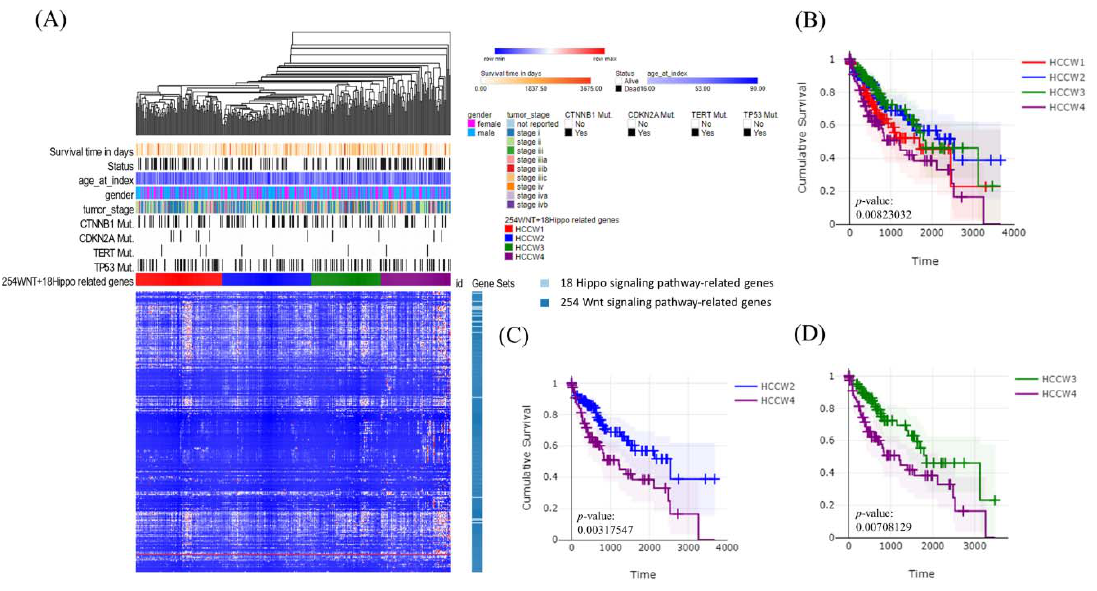
Figure 4. Molecular classification of HCC data from The Cancer Genome Atlas (TCGA) using a panel of 272 Wnt–Hippo pathway genes. ( A ) Heatmap showing normalized expression levels of 272 signature genes (rows) across subjects (columns) divided into four molecular subclasses (HCCW1– 4), where blue and red indicate low and high expression, respectively. Significant differences in demographic characteristics, clinical annotations, molecular subclasses, and hepatitis B and C virus infection status across subjects are shown at the top of the figure. ( B ) Overall survival for subjects in each molecular subclass. ( C ) HCCW2 showed significantly better prognosis than HCCW4 based on two ‐ sided log ‐ rank tests. ( D ) HCCW3 showed significantly better prognosis than HCCW4 based on two ‐ sided log ‐ rank tests.